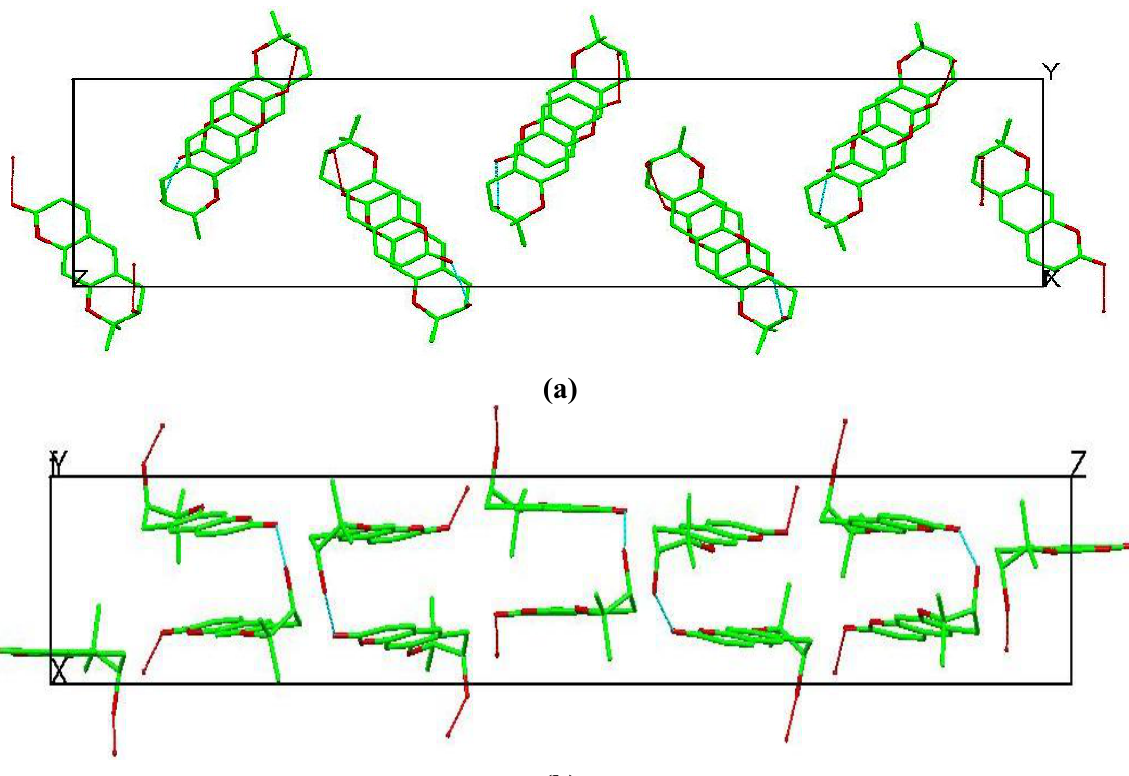
Figure 3. Crystal packing of aegelinol. ( a) Stacking along the a axis; ( b) Stacking along the b